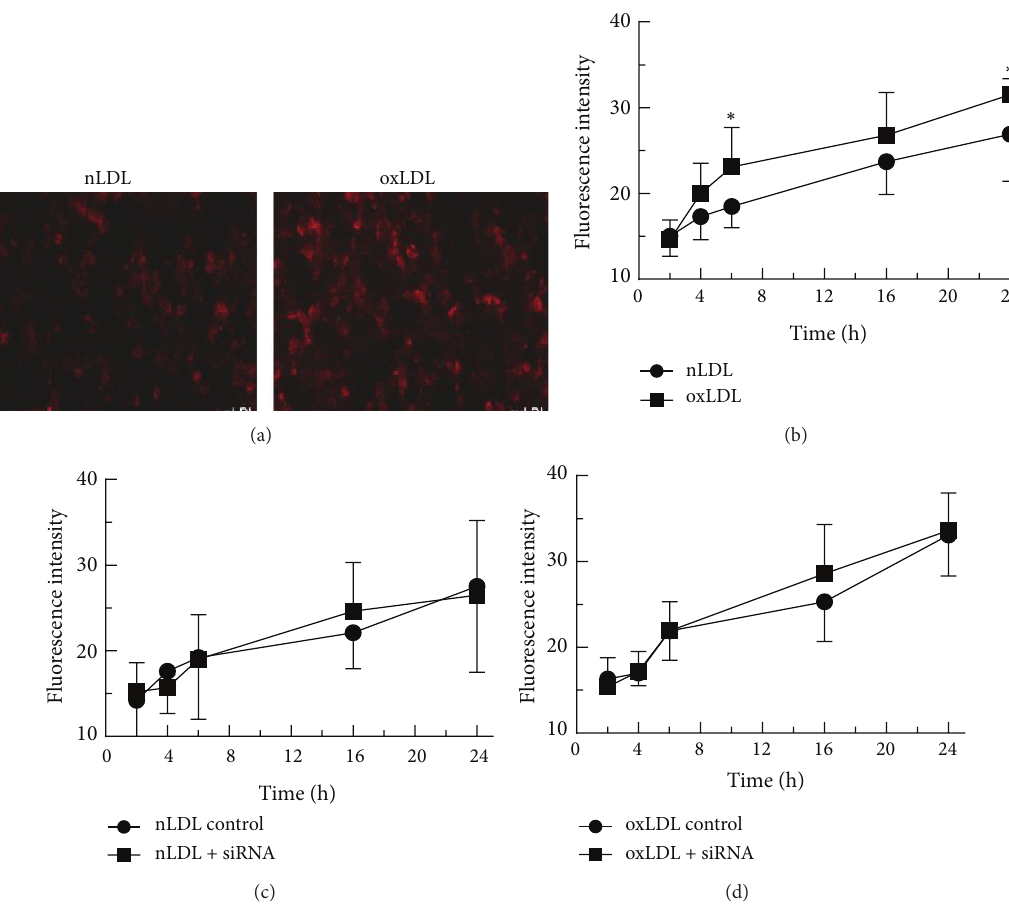
Figure 10: Effect of siRNA targeted to Myo6 on the uptake of LDL and oxLDL by THP-1 macrophages. (a), (b) THP-1 macrophages were incubated with nLDL or oxLDL (50 𝜇 g protein/mL) for 6 h (a) or time points up to 24 h (b), and the area of fluorescent signal associated with the cells was assessed using a Leica inverted DMIRB wide-field fluorescence microscope. (c), (d) THP-1 cells were transfected with siRNA targeting Myo6 or with a nonsilencing scrambled siRNA sequence (control) using HiPerFect transfection reagent. After 48h, cells were treated with 50 𝜇 g protein/mL DiI-labelled nLDL (c) or oxLDL (d) and fixed at time points up to 24 h. Wide-field images were taken using a Leica DMRIB fluorescence microscope. The mean intensities of the fluorescent signals ((b)–(d)) were measured using Volocity software. Data shown are the means from three separate experiments, and error bars show the SEM. Significance limits, ∗ 𝑃 < 0.05 versus nLDL (two way